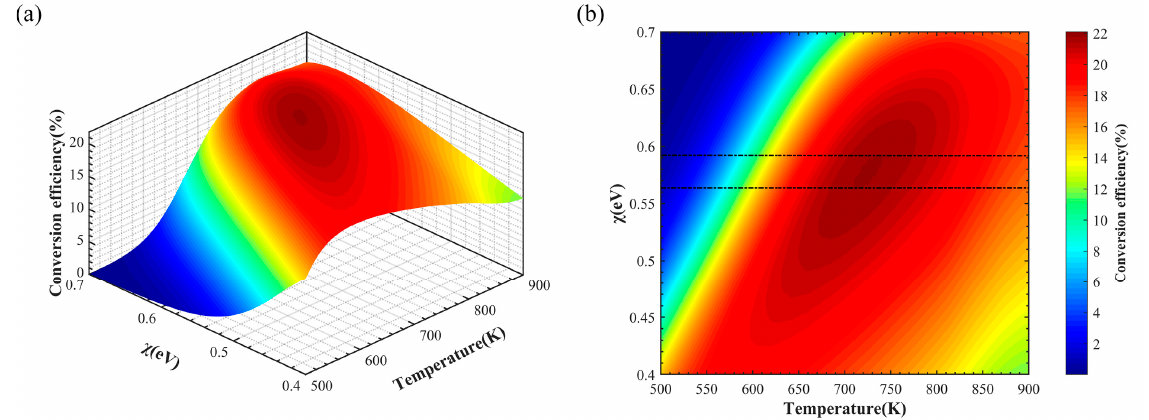
Figure 4. ( a ) The relationship of conversion efficiency with temperature and electron affinity under isothermal conditions, and ( b ) the vertical projection of the three-dimensional surface.